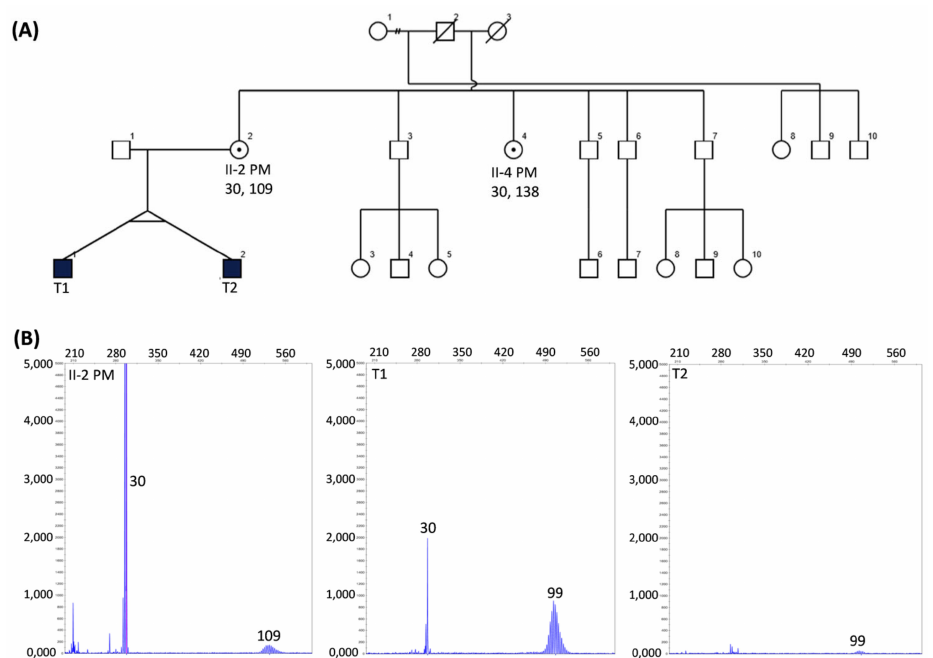
Figure 1. ( A ) Pedigree of the studied family, with squares and circles symbolising males and females, respectively. Black and while shapes indicate a ff ected and nona ff ected statuses, respectively. A small black circle in a white shape indicates carrier status. CGG size is indicated by numbers below each participant’s ID; ( B ) Capillary electrophoresis sizing using standard PCR, as previously described [14], with allele sizes indicated by numbers superimposed on the